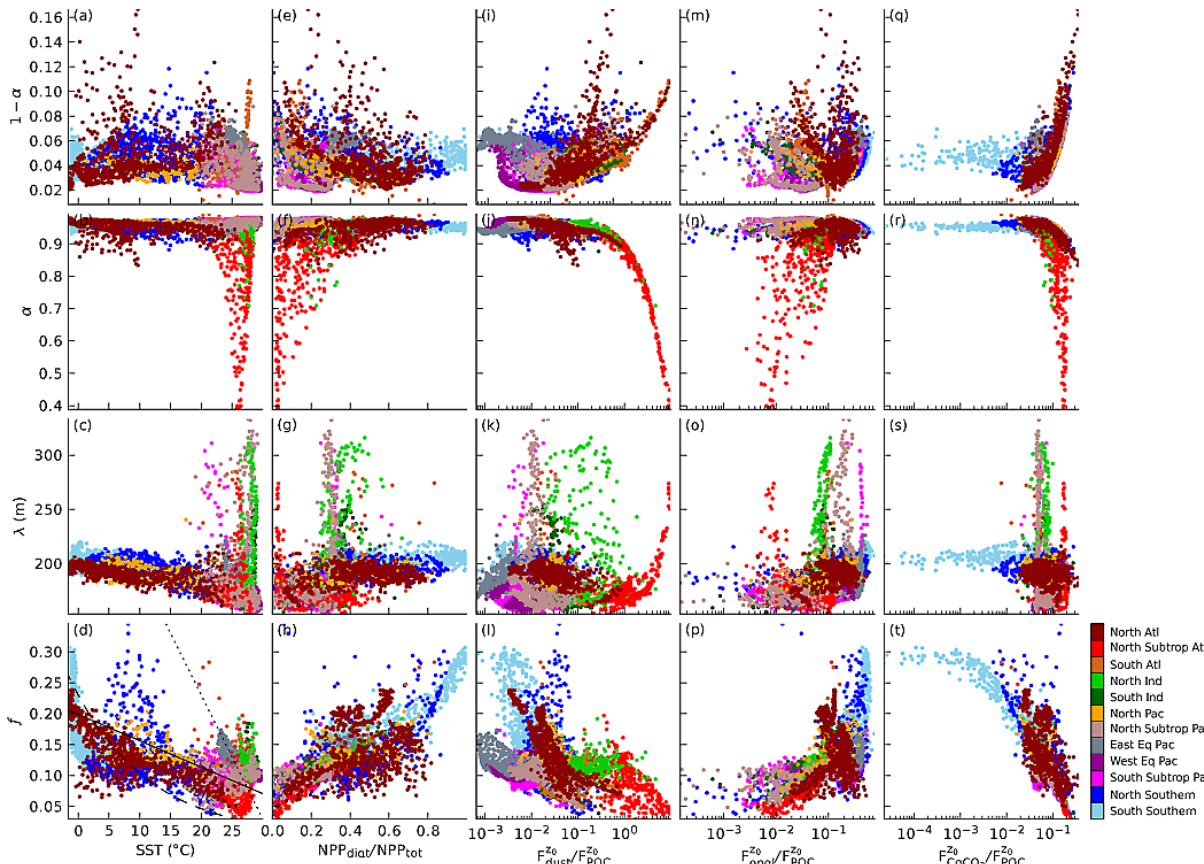
Fig. 8. 1 − α , α , λ and f obtained from fitting Eq. (1) to CCSM–BEC annual mean POC flux profiles and NPP plotted against annual means of sea surface temperature (SST) (a–d) , ratio of vertically integrated NPP by diatoms to total NPP (e–h) and the ratio of dust (i–l) , opal (m–p) and CaCO 3 (q–t) flux to POC flux at z 0 in CCSM–BEC. 1 − α is plotted with the regions of high atmospheric dust deposition (northern subtropical Atlantic and northern Indian Ocean) removed. Points are colored according to model domain region (Fig. 1). In (d) , the solid black line shows the type II linear regression between SST and estimated f values (correlation coefficient r = − 0 . 61, slope b = − 0 . 00427 ± 9 . 07 × 10 − 5 ), and the dashed and dotted lines show the f ratio as function of SST relationships of Henson et al. (2011) and Laws et al. (2000),